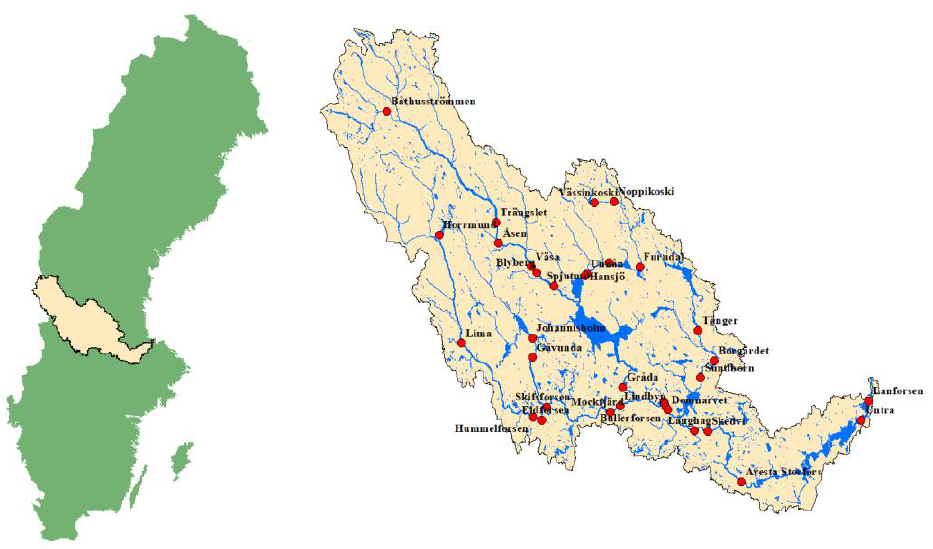
Figure 2. The Dalälven River basin with hydropower stations marked with red dots.